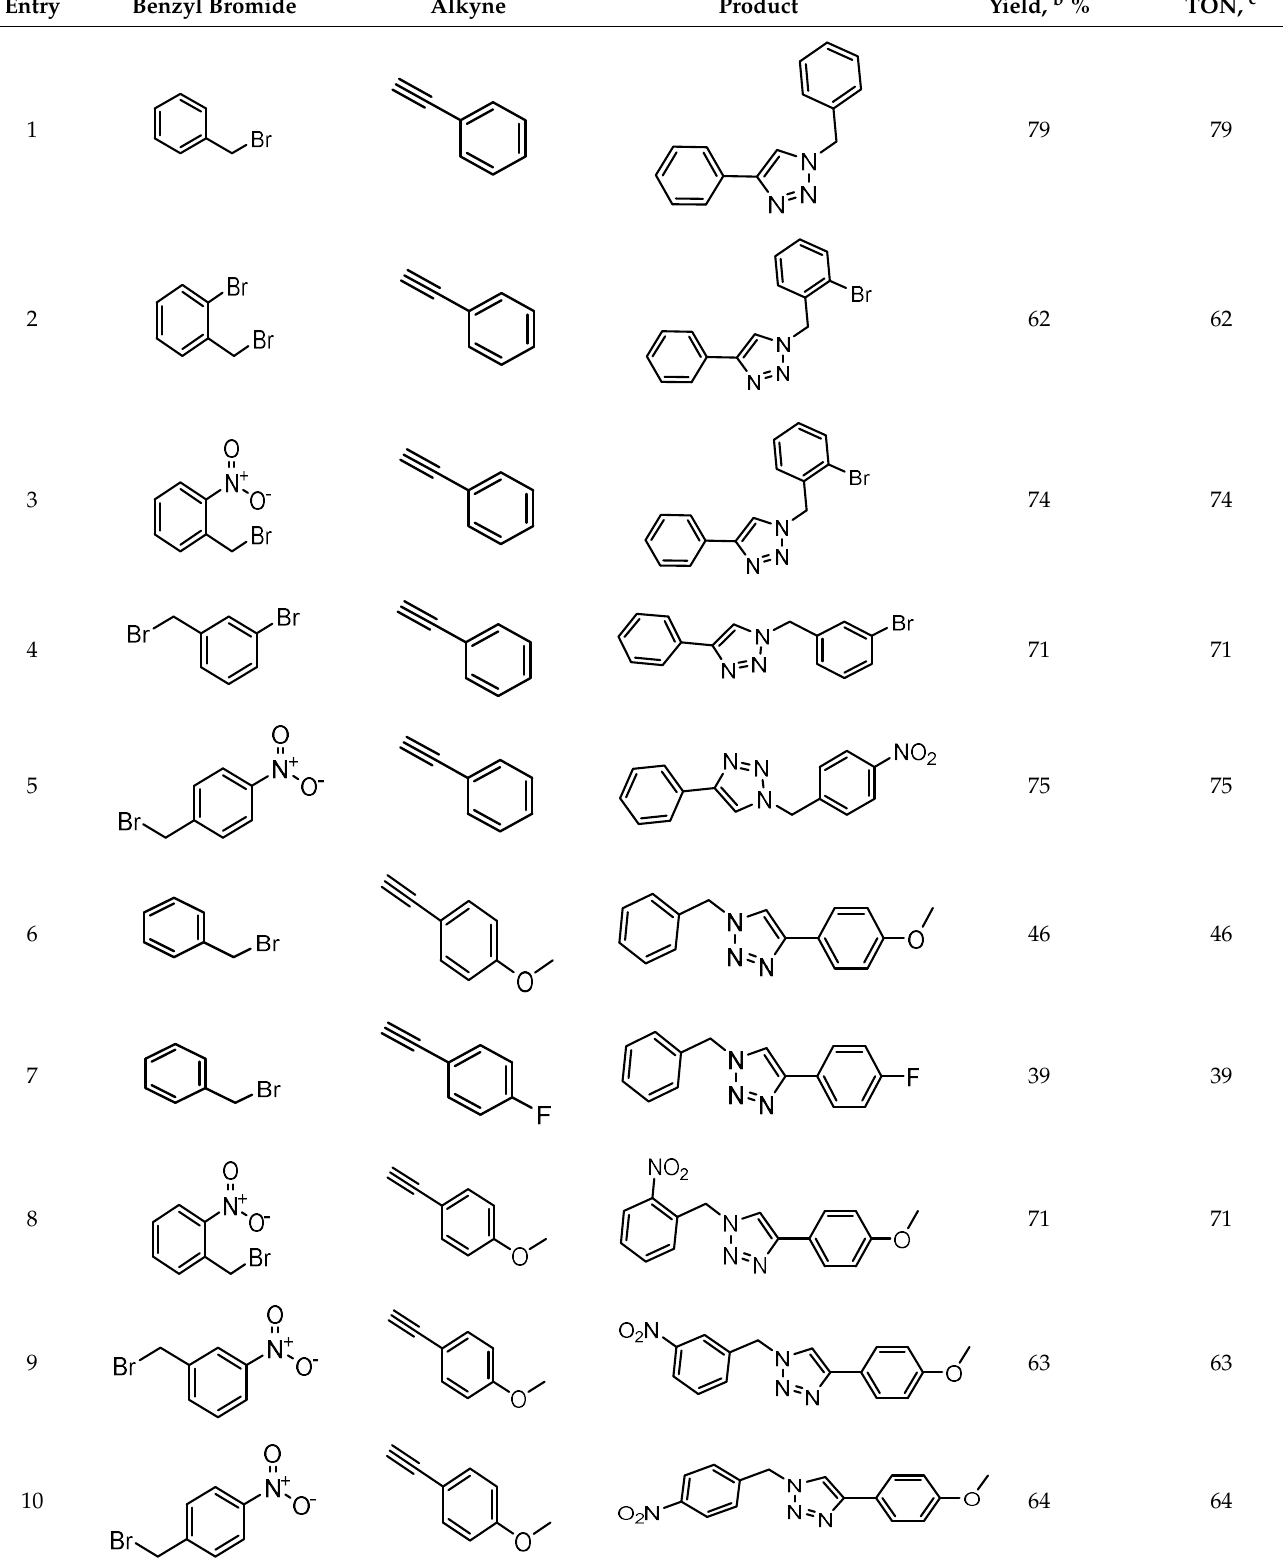
Table 4. Cycloaddition reaction of azides and alkynes catalyzed by Au/TiO 2 a .